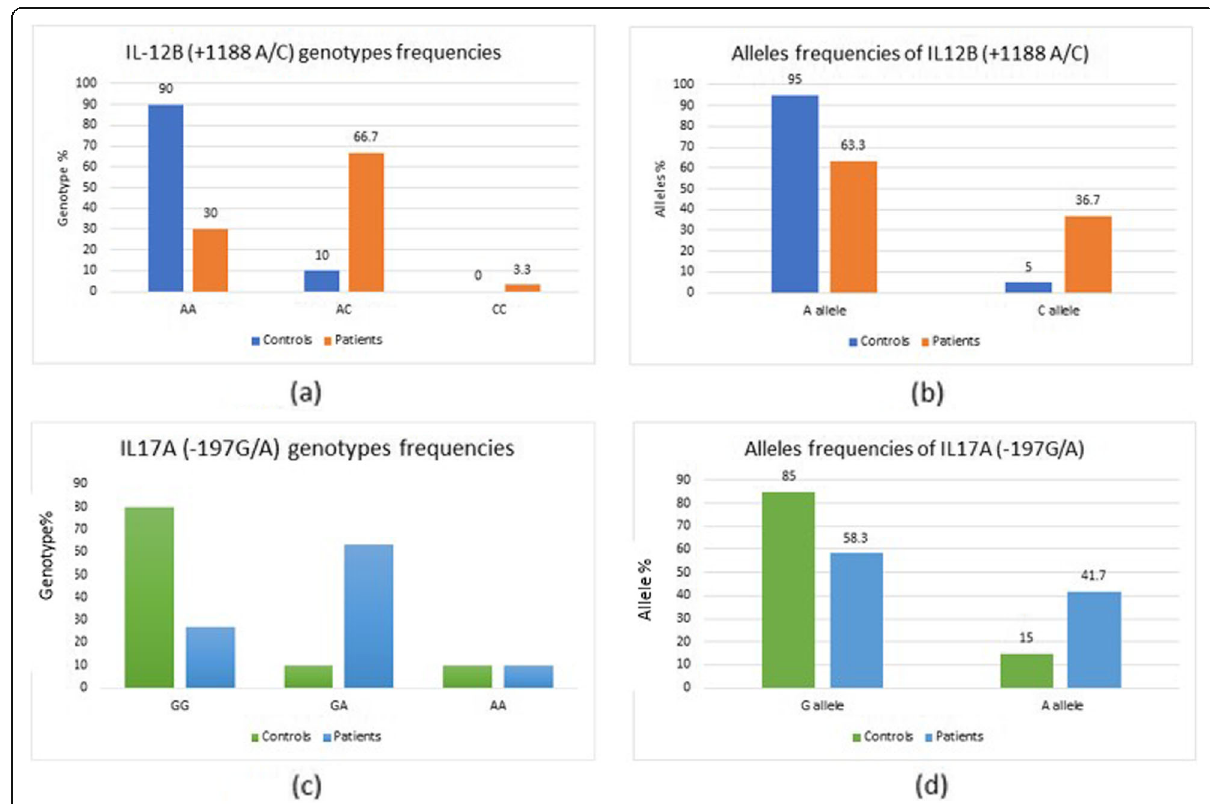
Fig. 5 a , b Genotypes and alleles frequencies of IL12B (1188 A/C) in patients and controls. c , d Genotypes and alleles frequencies of IL17A ( − 197G/A) in patients and controls. Polymorphisms are represented as a